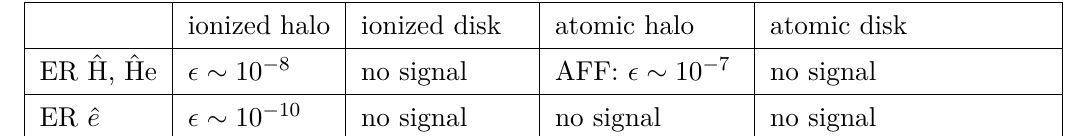
Table 3 . Summary of existing constraints on dark photon mixing (cid:15) from direct detection of mirror baryons and electrons via electron recoil at Xenon10. Here we assume r scale with r − 1 / 2 (cid:12)